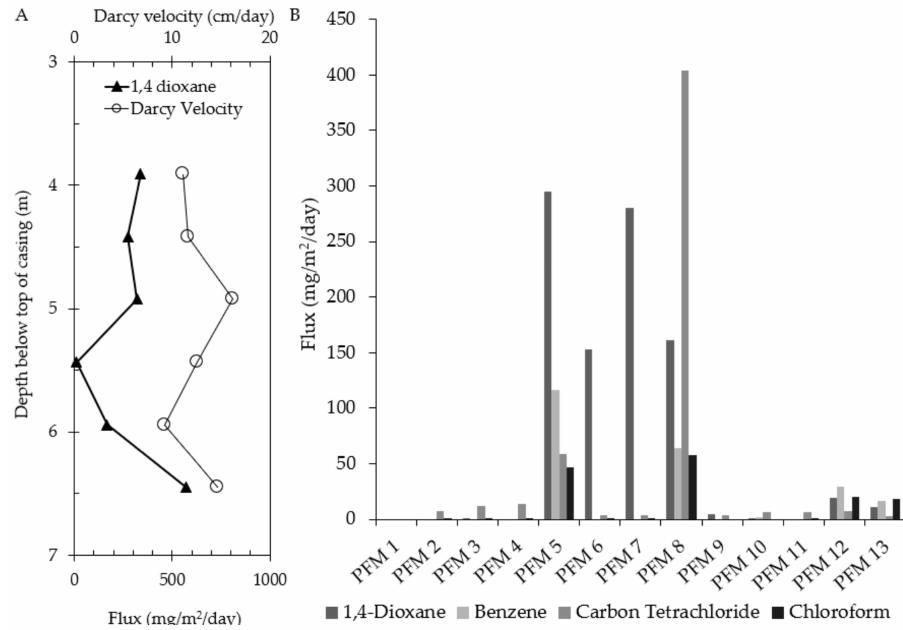
Figure 5. Mass flux measurements at Site 1 (confidential site). ( A ) Water and 1,4-dioxane flux profiles for PFM-7 and ( B ) Average mass flux of contaminations for each well at Site